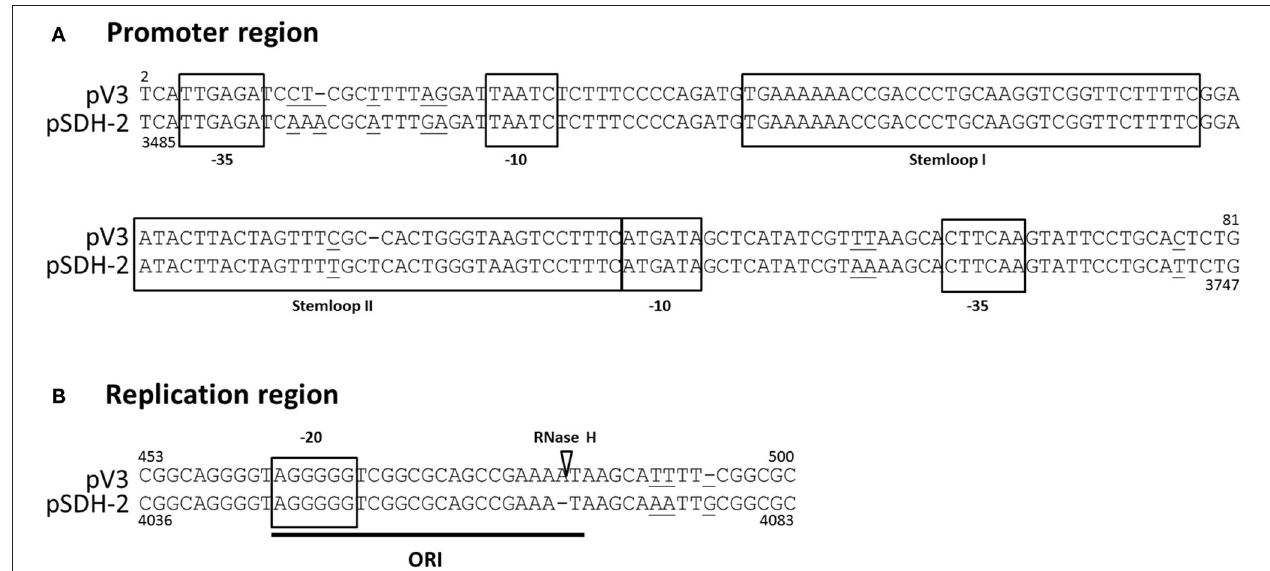
FIGURE 3 | Alignment of putative promoter (A) and replication (B) regions of pSDH-2 with corresponding regions of the CLV origin of plasmid pV3 (GU272161.1; Pan et al., 2010 ). The main features of the CLV origin are indicated by boxes and their function is indicated. Nucleotides that differ between the two sequences are underlined. The RNase H cleavage site is indicated by a white triangle. Positions on the nucleotide sequences of pSDH-2 and pV3 are indicated below and above the alignment, respectively.